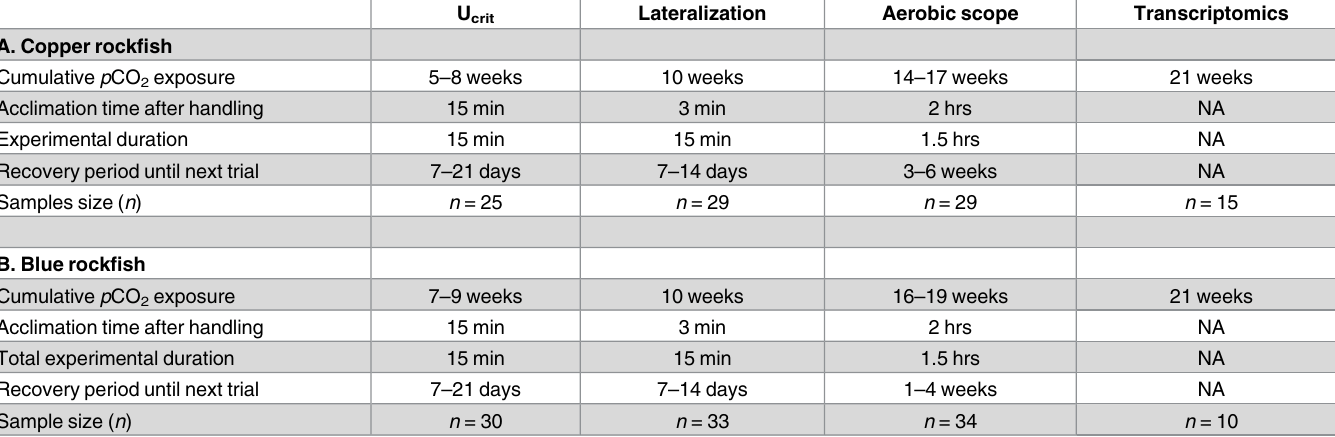
Table 2. Summaryof the range of exposure duration, acclimation time, time per trial, recoveryperiod, and sample size for copper and blue rock- fish used to test behavioral and physiological responses to elevated p CO 2 . Note: Individualfish were used successively in the different trials to enable tracking of performance measures. Data from fish that did not behavenormally in a particular trial were excluded(e.g., refusal to swim in the U crit test). In addi- tion, 2 of 12 bluerockfish individualsthat were sequencedhad low quality reads and were subsequently excludedfrom the differentialgene expression